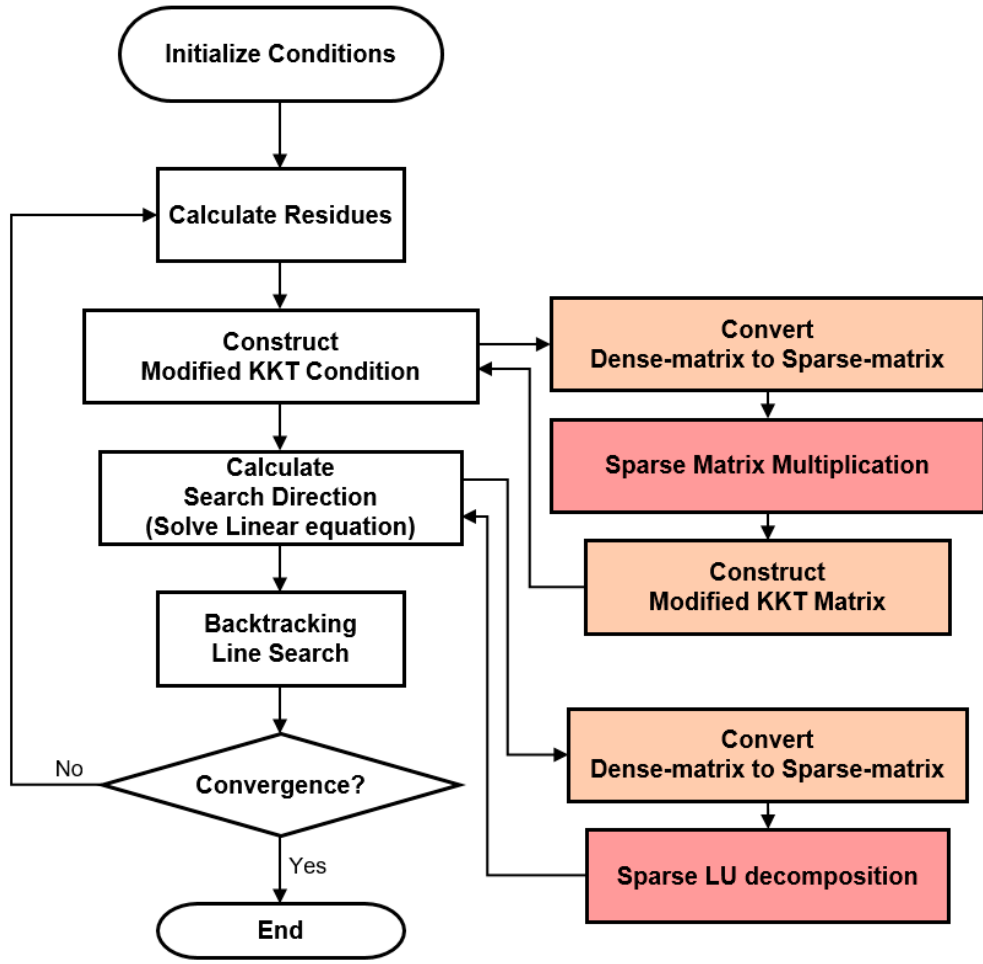
Figure 2. The flowchart of the proposed method.